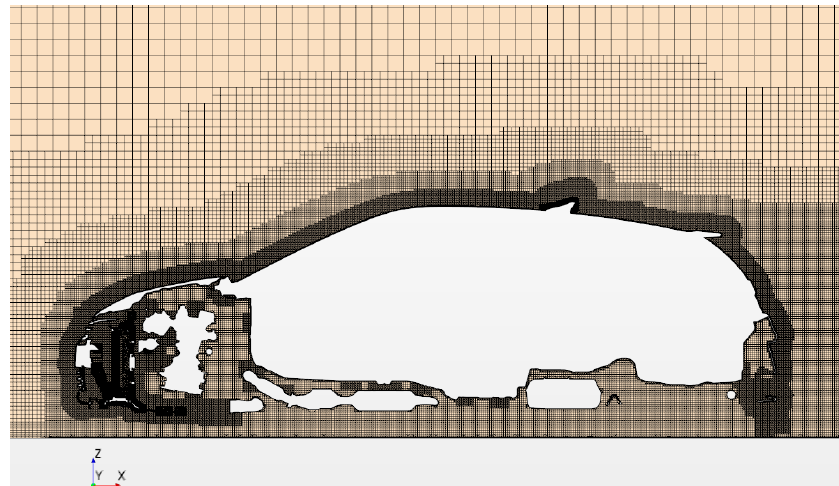
Figure 5. The mesh on the central plane of the vehicle.